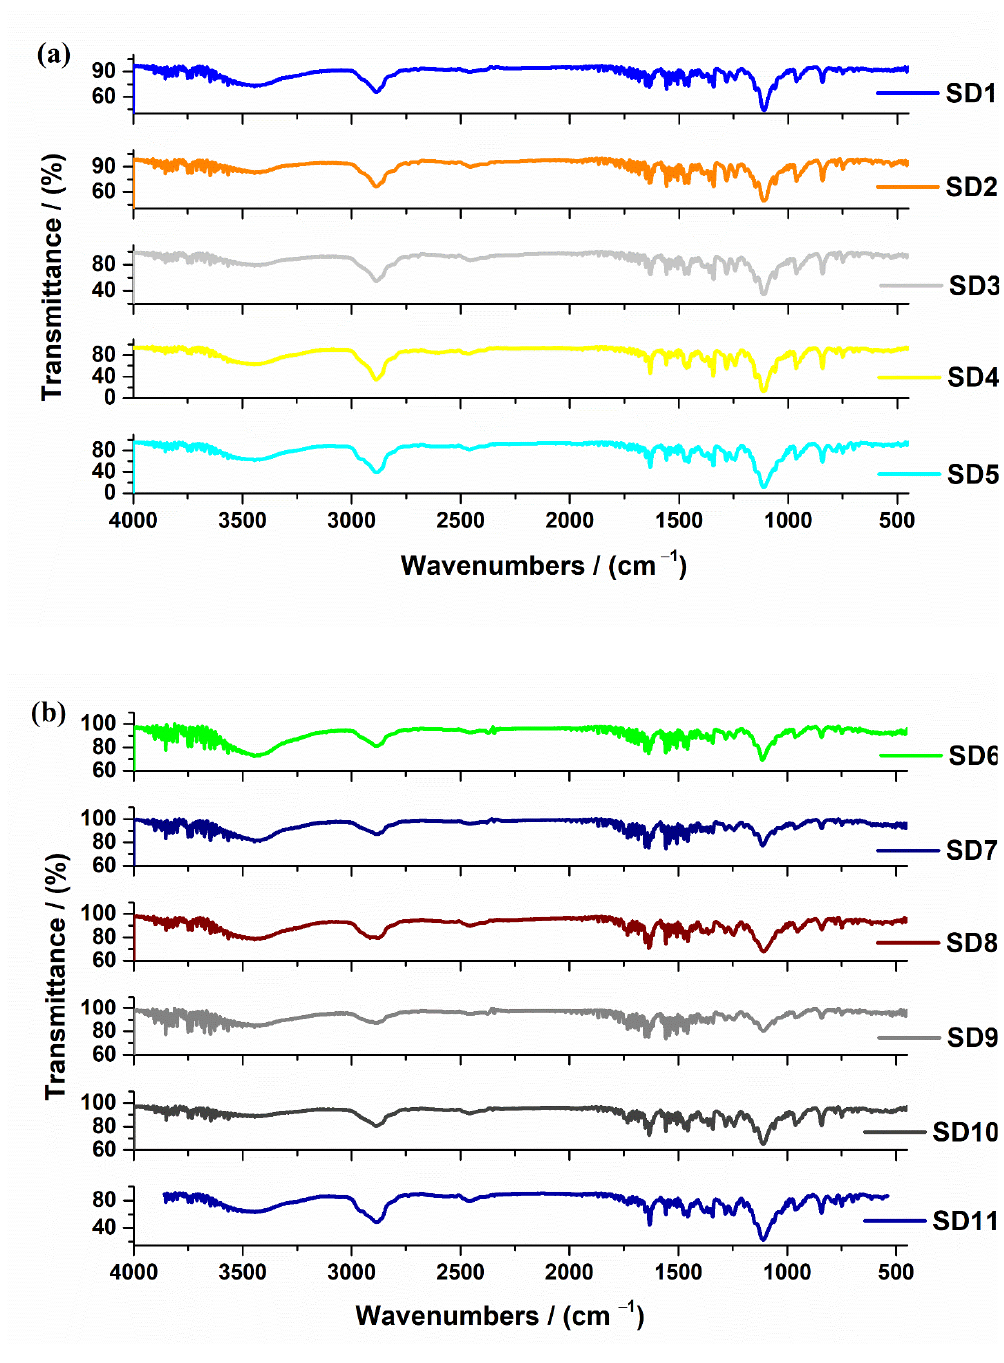
Figure 6. FTIR spectra of studied solid dispersions ( a ) SD1–SD5; ( b ) SD6–SD11. According to data in the literature, Soluplus® showed peaks at 3448 cm − 1 due to O–H stretching, at 2927 cm − 1 due to aromatic C–H stretching, at 1735 cm − 1 and 1635 cm − 1 due to C=O stretching, and at 1477 cm − 1 due to C–O–C stretching. All these peaks are observed in the FTIR spectra of studied solid dispersions which contain Soluplus ® (SD7–SD11) [49,50]. The FTIR spectra of AMH show the presence of C–H stretching vibration bands from methyl groups at 2977, 2963 and 2858 cm − 1 , the C–H stretching from methylene groups at 2933, 2918 and 2880 cm − 1 . At 1477 cm − 1 (asym) and 1381 cm − 1 (sym) appear C–H deformation vibrations from C–CH3 bonds, while for those from the methylene group, they appear at 1454 and 1432 cm − 1 . At 3040 cm − 1 , the =C–H appears to stretch from the aromatic structure, while in 900–860 spectral range the in-plane deformation of